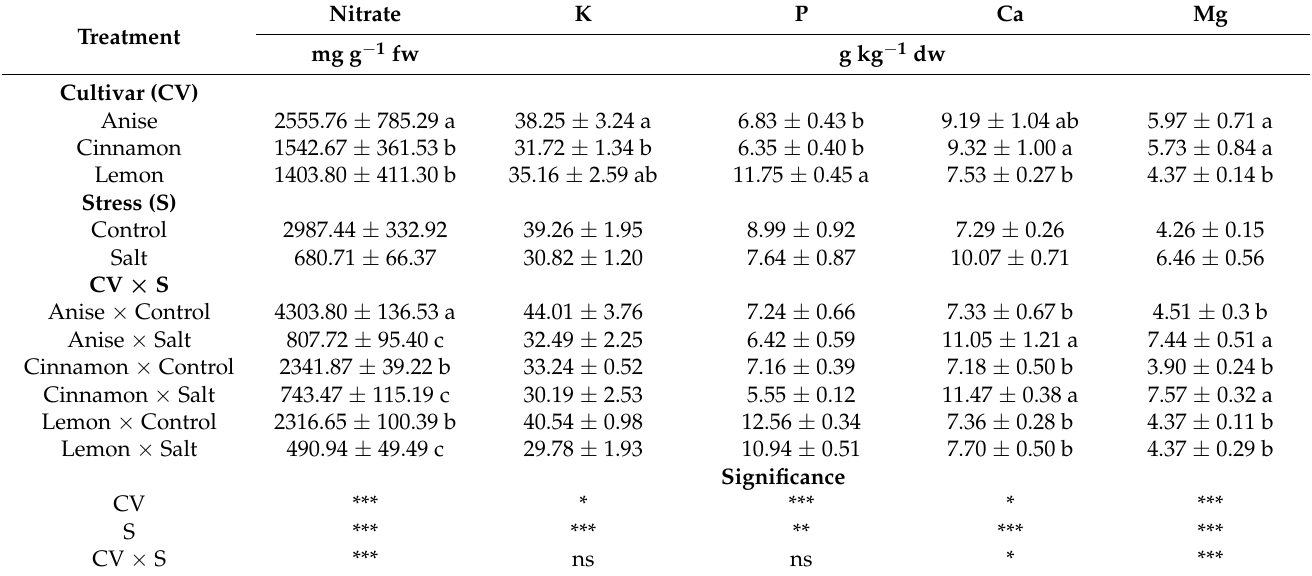
Table 5. Effect of basil cultivars (CV) and stress (S) on Nitrate, K, P, Ca, and Mg leaf